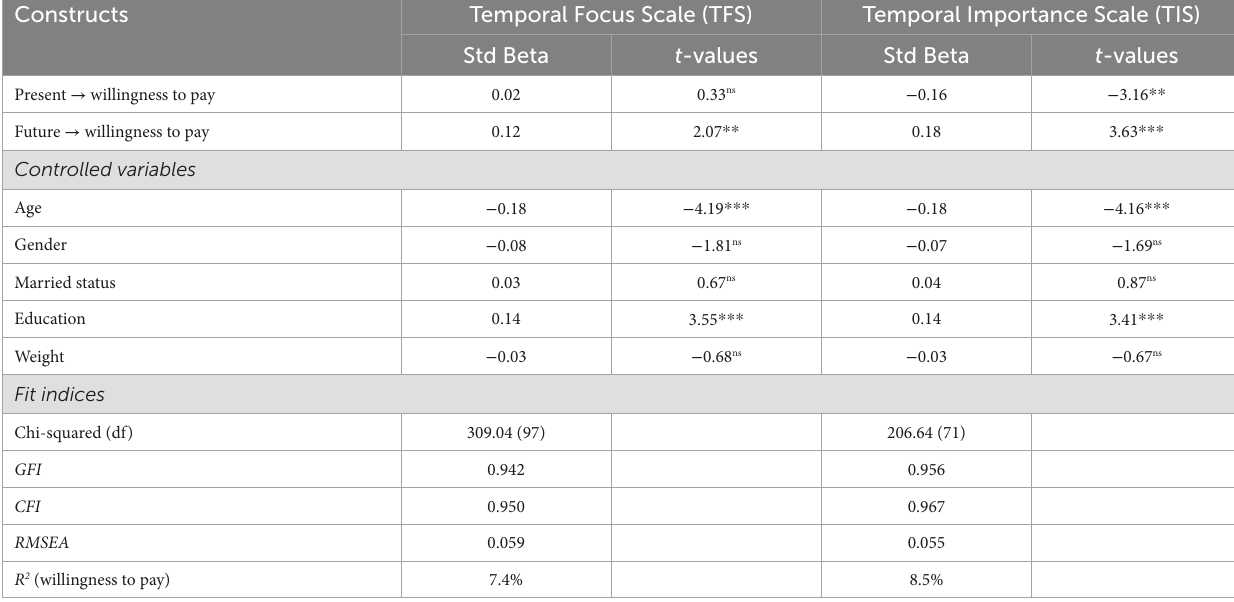
relative strength of the (asymmetric) relationships in the two different models. A comparison of the models using the two scales revealed that the goodness-of fit statistics are satisfactory for both scales: TIS ( GFI = 0.935; CFI = 0.962; RMSEA = 0.049; R 2 = 20.4%) and TFS ( GFI = 0.924; CFI = 0.948; RMSEA = 0.052; R 2 = 21.7%). For the TPAM model (Model 1b), biospheric values have significant relationships with future focus and importance ( β = 0.24, t = 5.04, p < 0.001 and β = 0.47, t = 10.89, p < 0.001, respectively), but